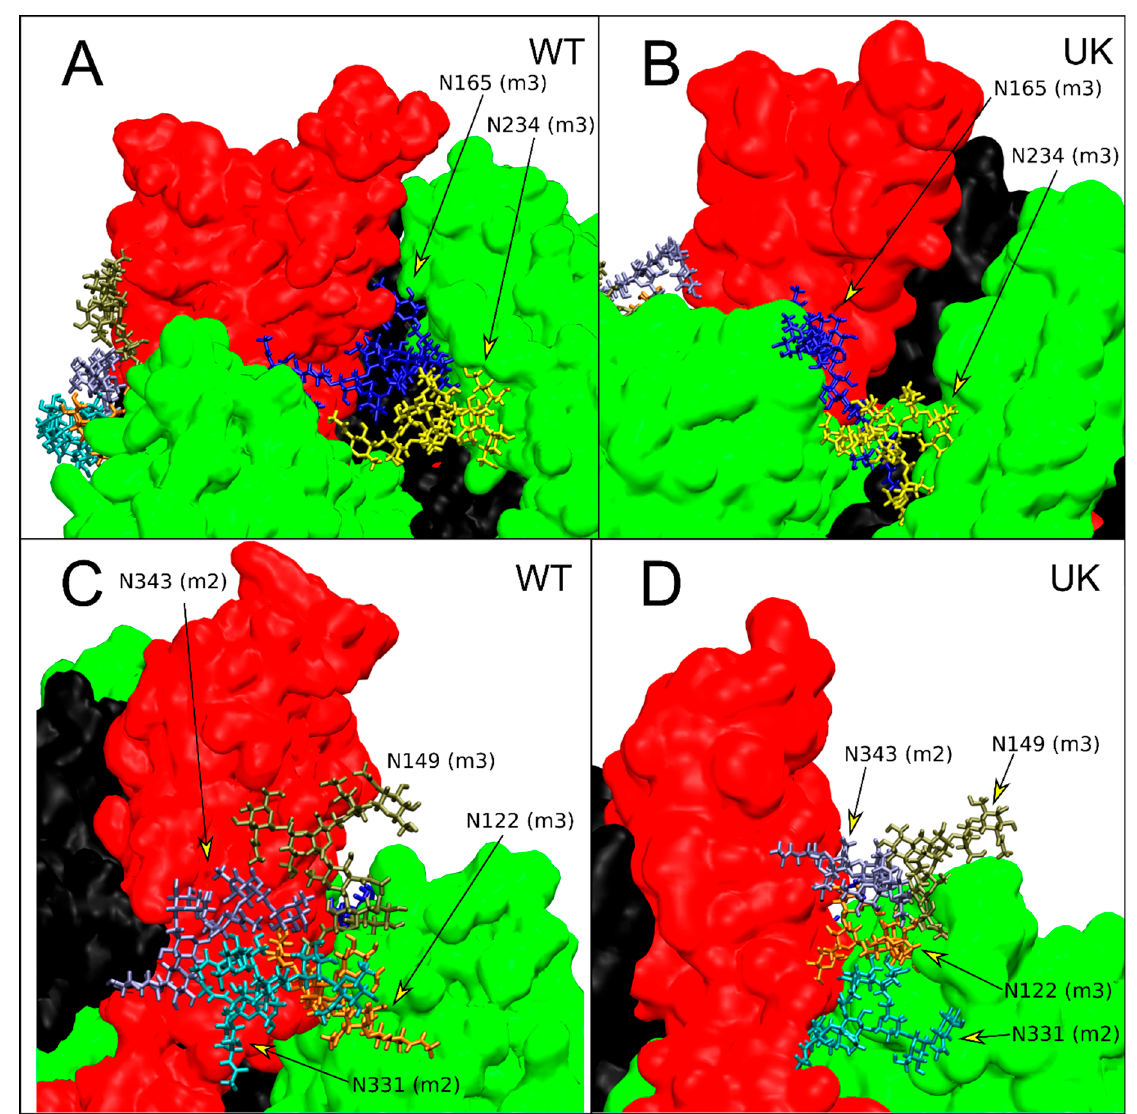
Figure 6. Interactions of N-glycans with RBD domain in up conformation (monomer 2, red color). Monomer colors as in Figure 1C. ( A , B ) Enlargement of the region of interaction of N165 and N234 of monomer 3 (green color) for WT and UK, respectively. ( C , D ) Enlargement of the region of interaction of N122 and N149 of monomer 3; N331 and N343 of monomer 2 (red color) for WT and UK, respectively. For each residue, the monomer to which they belong is reported in parentheses.